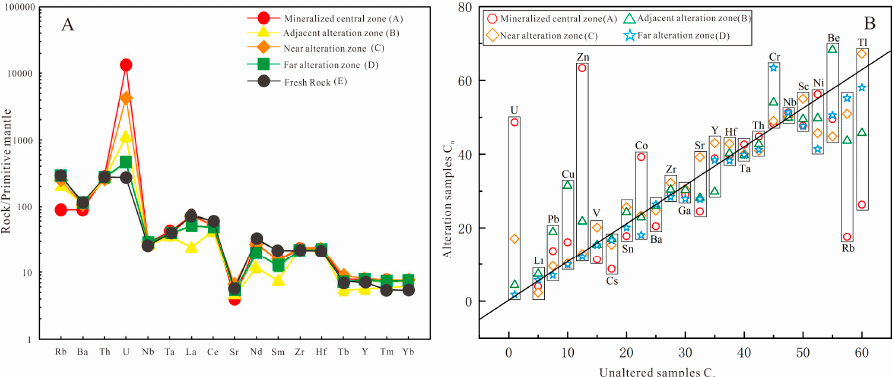
Figure 7. ( A ) Primitive mantle-normalized trace element spider diagram (normalization values after ref. [24]) and ( B ) standardized Isocon diagram for trace elements.